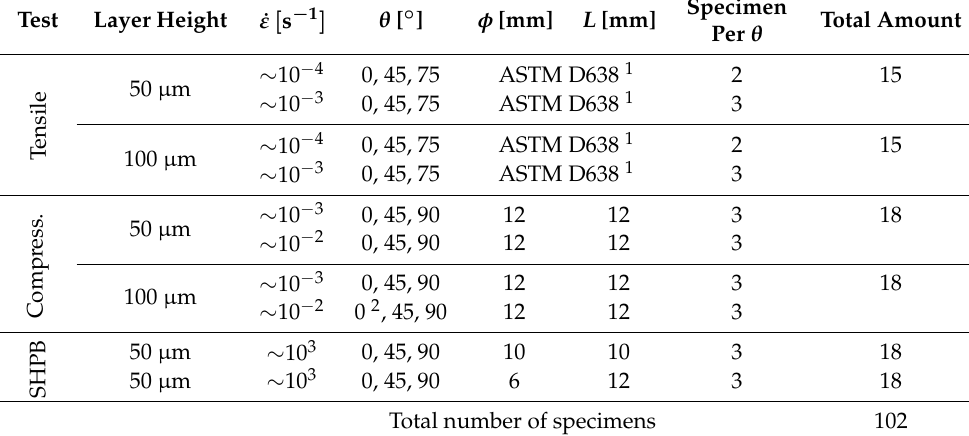
Table 1. Summary of tests